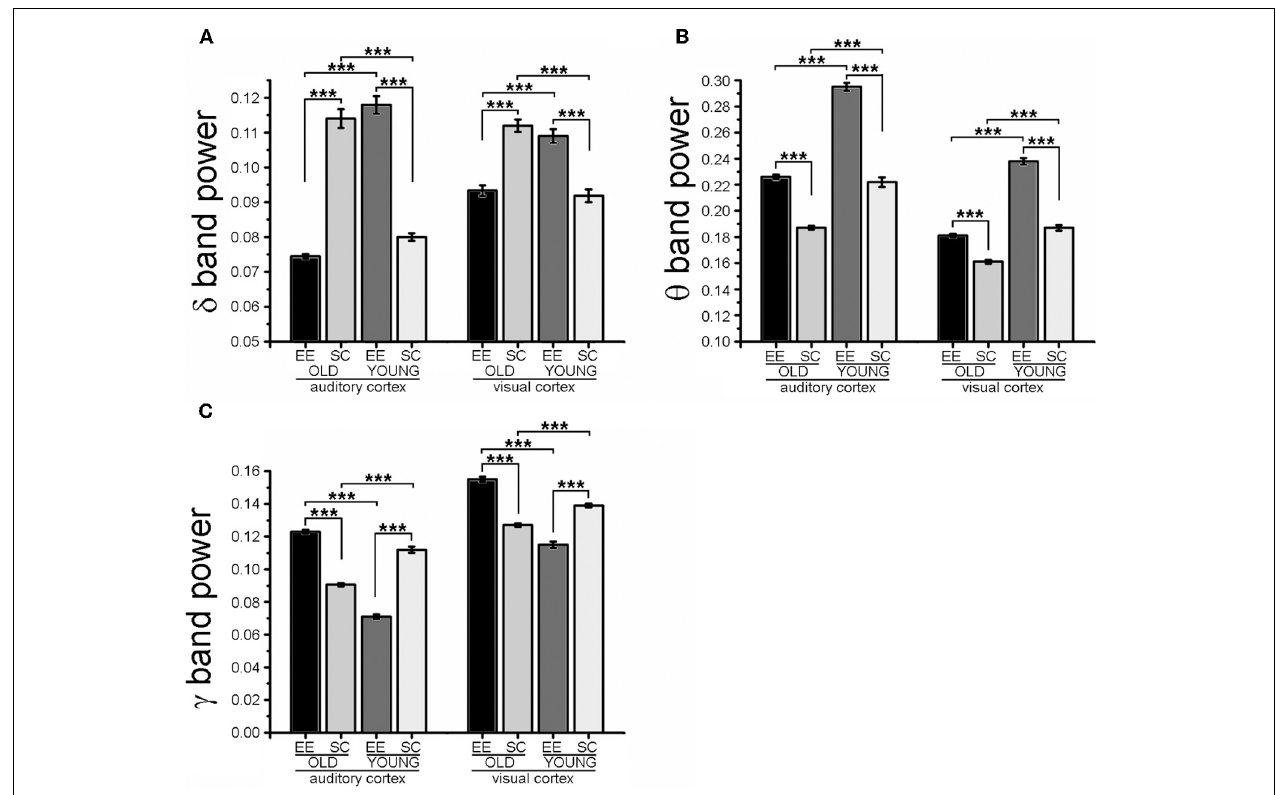
FIGURE 3 | Fourier analysis of spectral power in the δ , θ , and low- γ EEG bands. The histograms show the results obtained with Fourier analysis in order to compute the spectral power of LFP in the δ (A) , θ (B) and low- γ (C) bands for auditory (A1) and visual (V1) cortices. For each cortical area, spectral powers for EE-OLD, SC-OLD, EE-YOUNG and SC-YOUNG groups were compared and statistical significance was assessed with Three-Way ANOVA followed by Holm-Sidak post-hoc test ( ∗∗∗ p < 0 . 001). (A) In the δ band, a statistically significant interaction between rearing condition, age and cortical area was found (Three-Way ANOVA, rearing × age × area interaction, p < 0 . 001). EE-OLD mice displayed lower LFP power than SC-OLD animals (rearing × age interaction, p < 0 . 001 and Holm-Sidak post-hoc test, p < 0 . 001 for both A1 and V1), whereas the opposite was observed when comparing the EE-YOUNG and SC-YOUNG groups (Holm-Sidak post-hoc test, p < 0 . 001